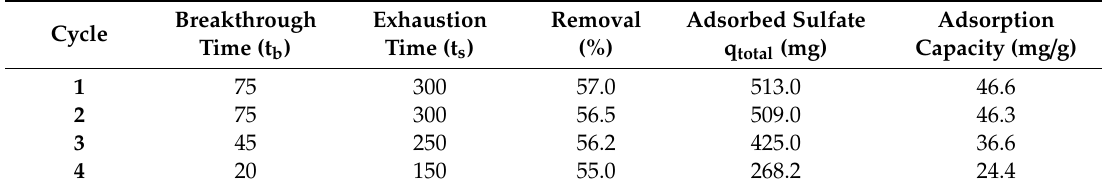
Table 6. Breakthrough curves parameters of sulfate adsorption on Ca–CP for cycles 1 to